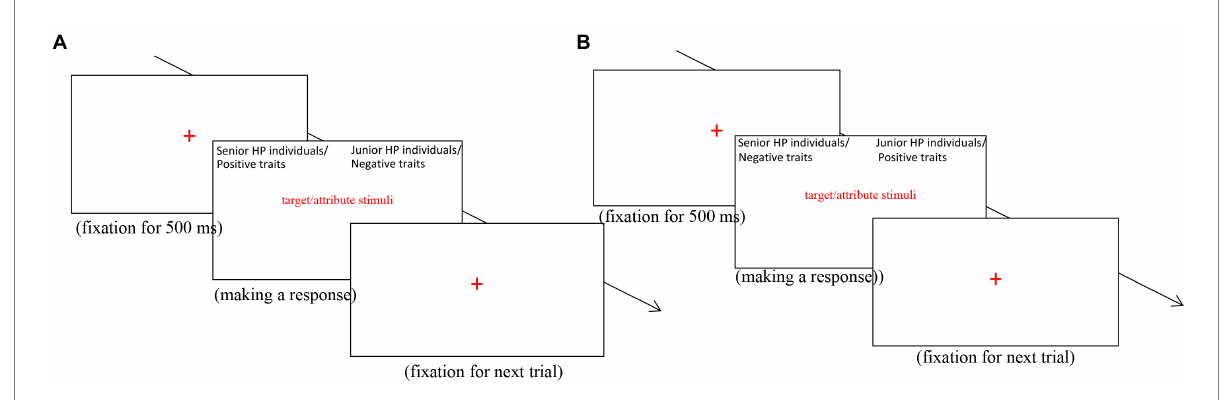
FIGURE 1 The trial structure in Part 3 and 4 of the IAT (A) and the trial structure in Part 6 and 7 of the IAT (B) were schematically